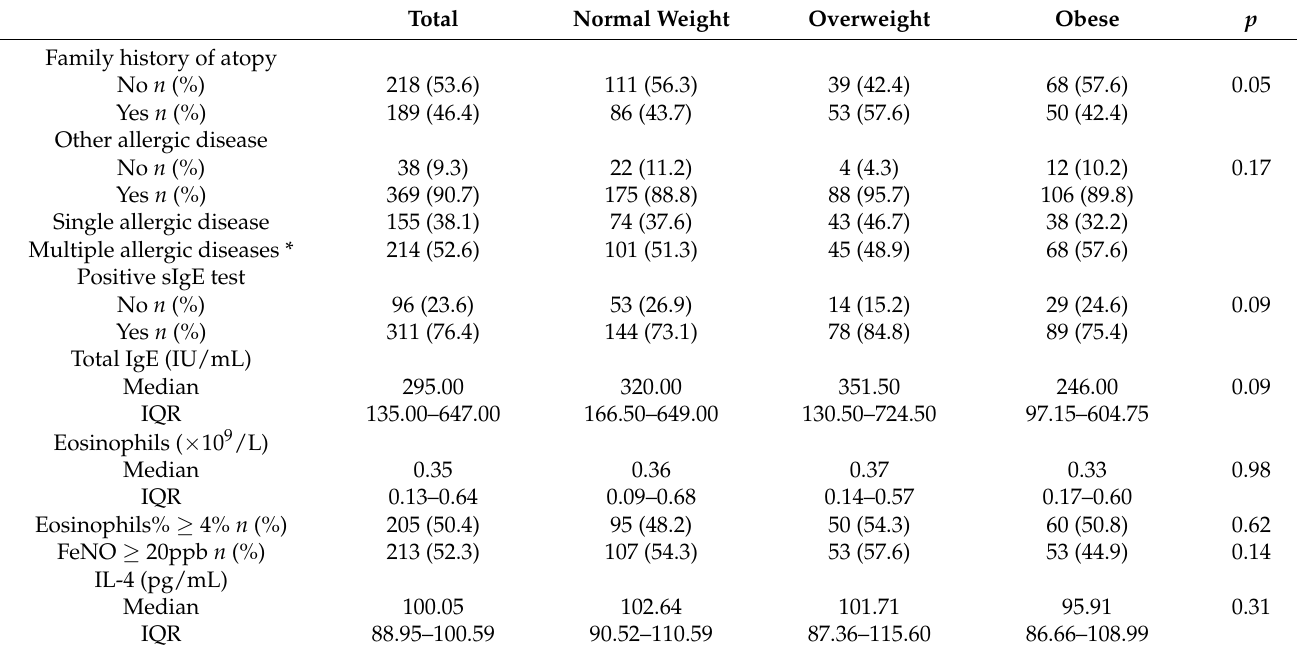
Table 3. Sociodemographic, clinical, and immunologic features of the three groups. Total Normal Weight Overweight Obese